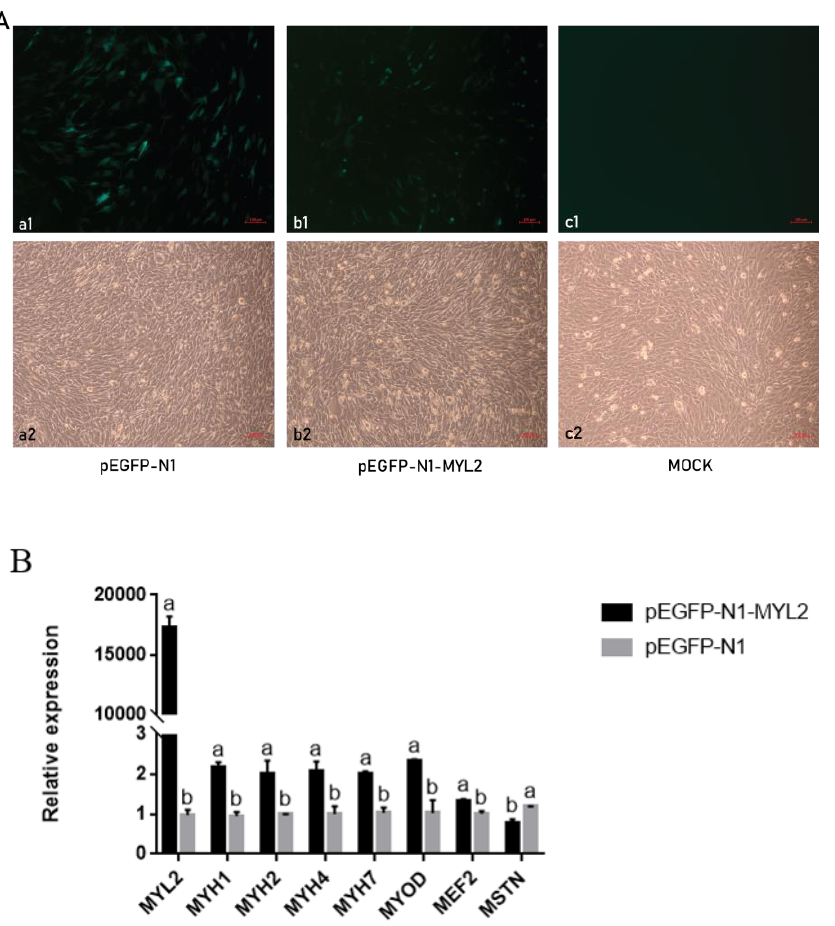
Figure 5. ( A ) The plasmid was transfected into C2C12 cells. ( a1 – c1 ), cells were observed under a fluorescence microscope at 10 × ; ( a2 – c2 ), cells observed under an optical microscope at 10 × . ( a1 , a2 ), cells transfected with pEGFP-N1; ( b1 , b2 ), cells transfected with pEGFP-N1-MYL2; ( c1 , c2 ), blank control group. ( B ) The mRNA expression change of MYL2, MYH1, MYH2, MYH4, MYH7, MYOD, MEF2 and MSTN after transfecting an overexpression vector of MYL2 into C2C12 cells. Different letters indicate a significant difference ( p < 0.05). All of the results are expressed as means ± SD.